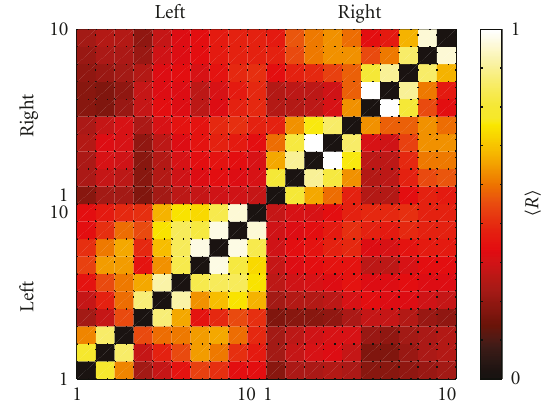
Figure 5: Same as Figure 4 but for the averaged mean phase coherence (cid:8) R (cid:9) . EEG data were low-pass filtered with a 3rd-order Butterworth filter and the cuto ff -frequency set to